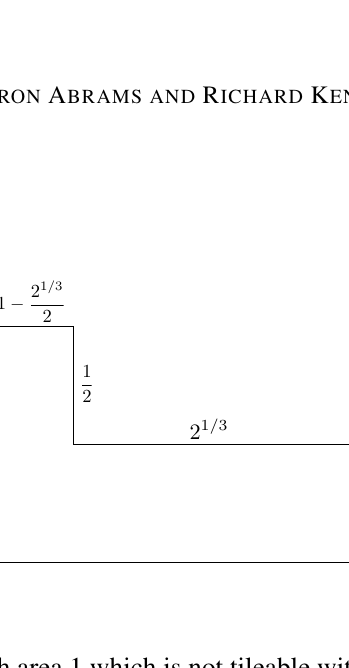
Figure 1: A polygon with area 1 which is not tileable with rational-area